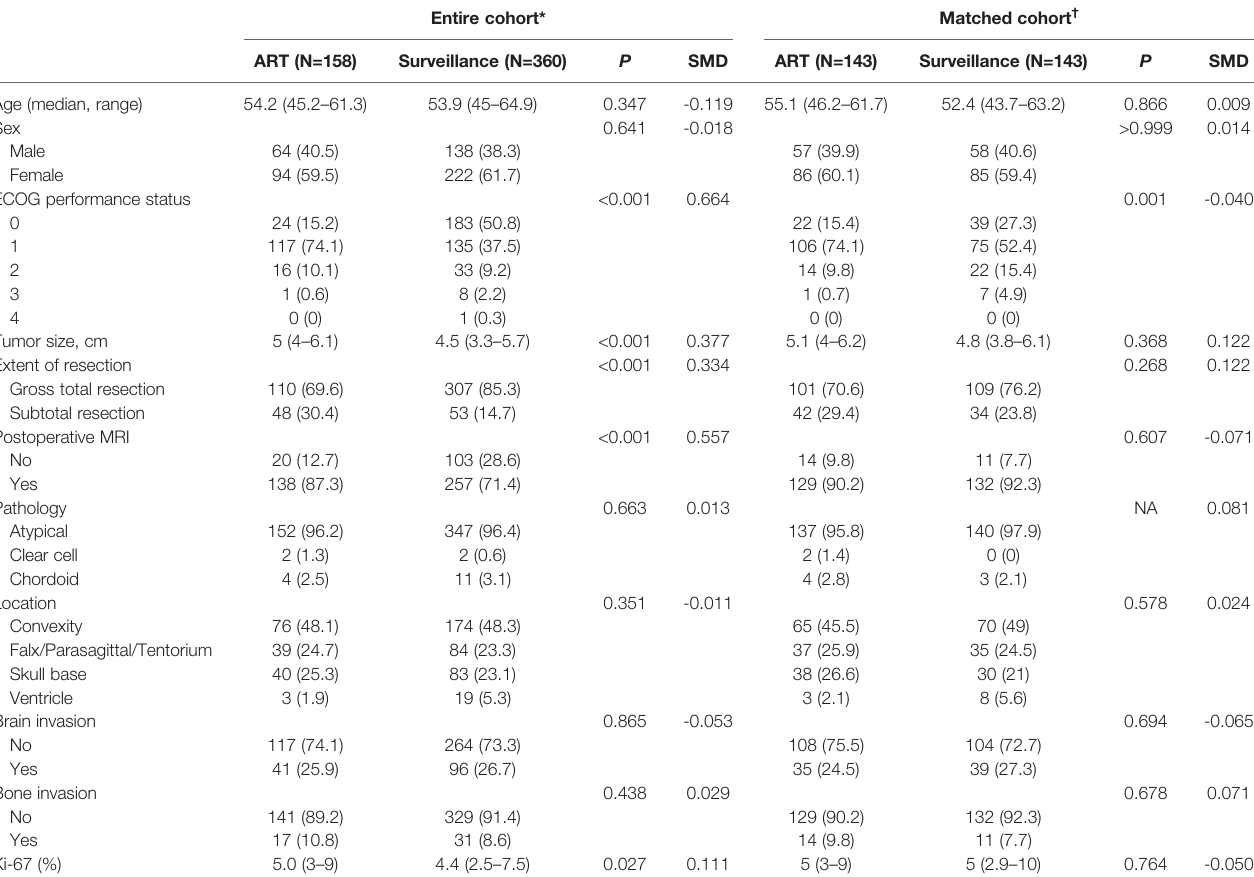
TABLE 1 | Baseline characteristics in the entire and matched